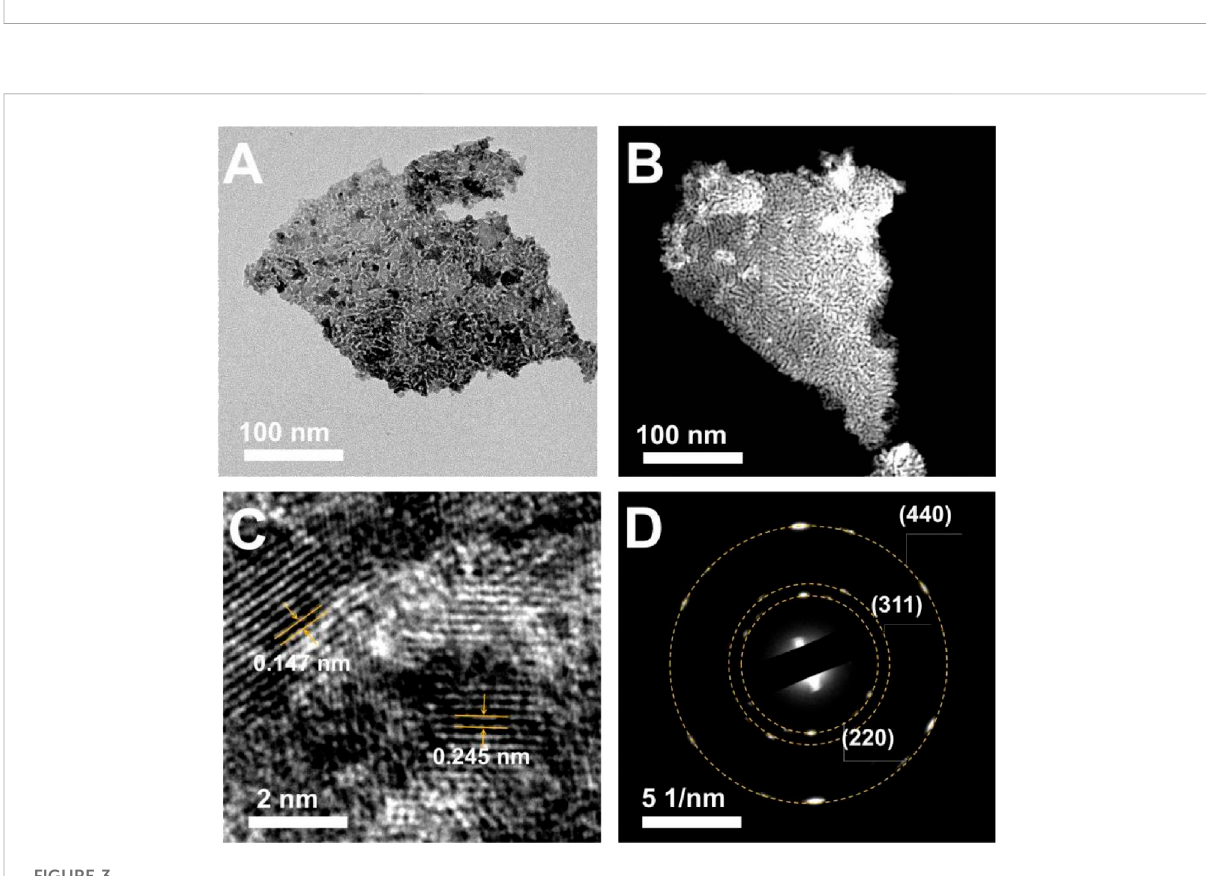
FIGURE 3 (A) TEM and (B) SEM images of Mo-Co 3 O 4 (heated at 250 ° C, cooled at − 40 ° C). (C) HRTEM and (D) the corresponding Fourier transform (FFT) patterns of